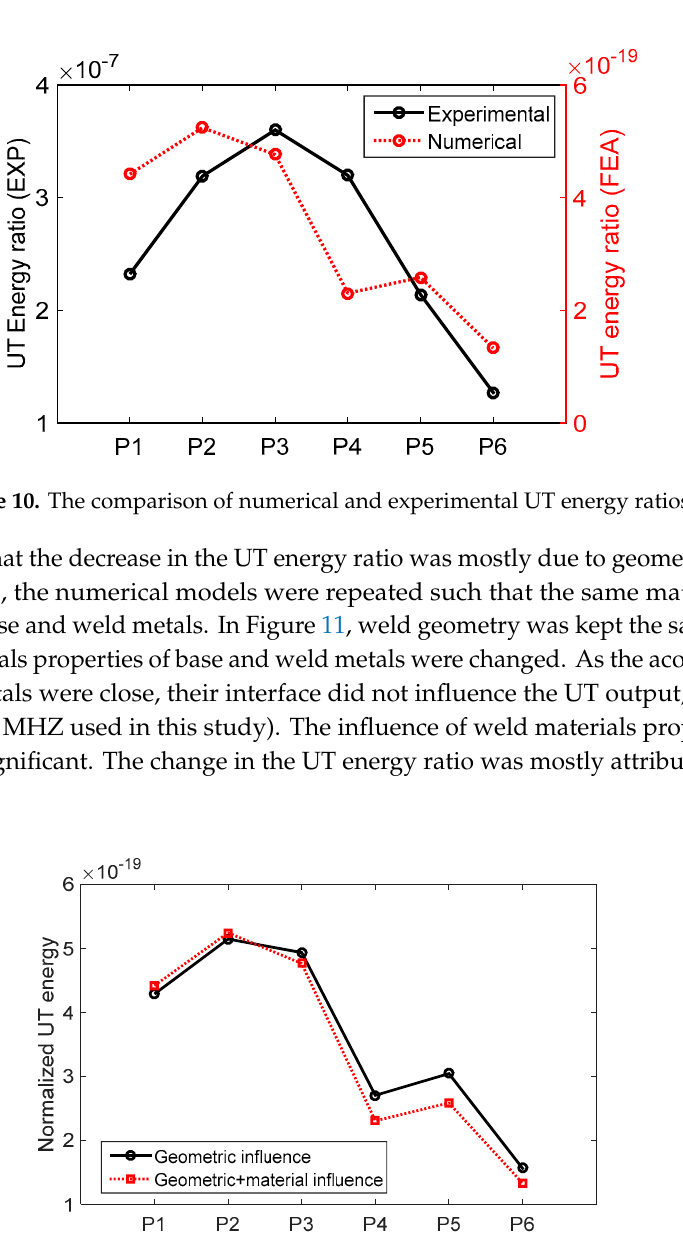
Figure 11. The comparison of geometric influence only and geometric + material influence.